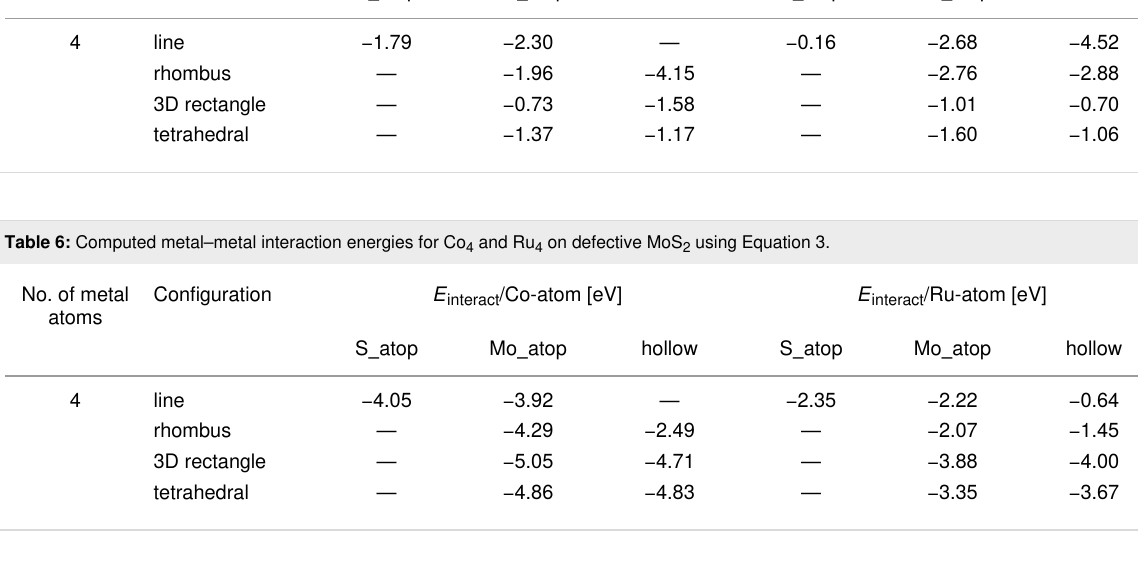
Table 5: Computed metal–substrate interaction energies Co 4 and Ru 4 on defective MoS 2 ML for various atom configurations using Equation 2. No. of metal atoms